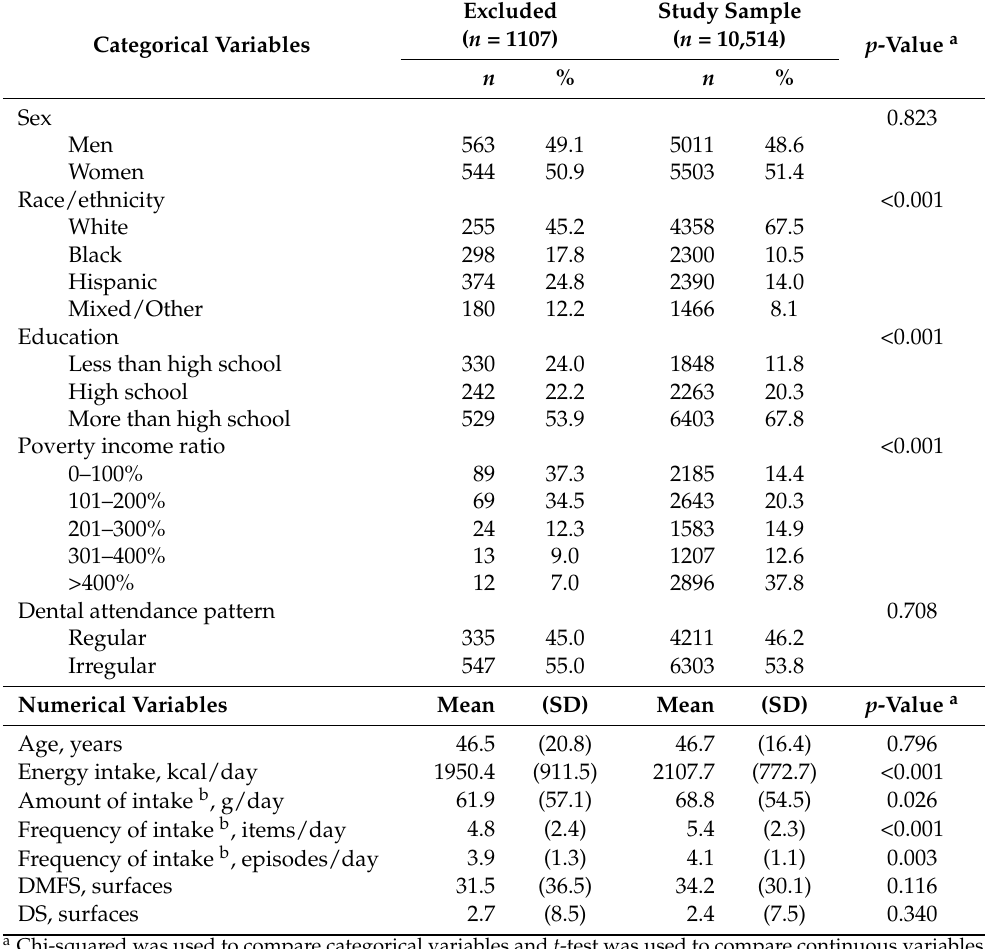
Table 1. Characteristics of the study sample and comparison against participants excluded because of missing